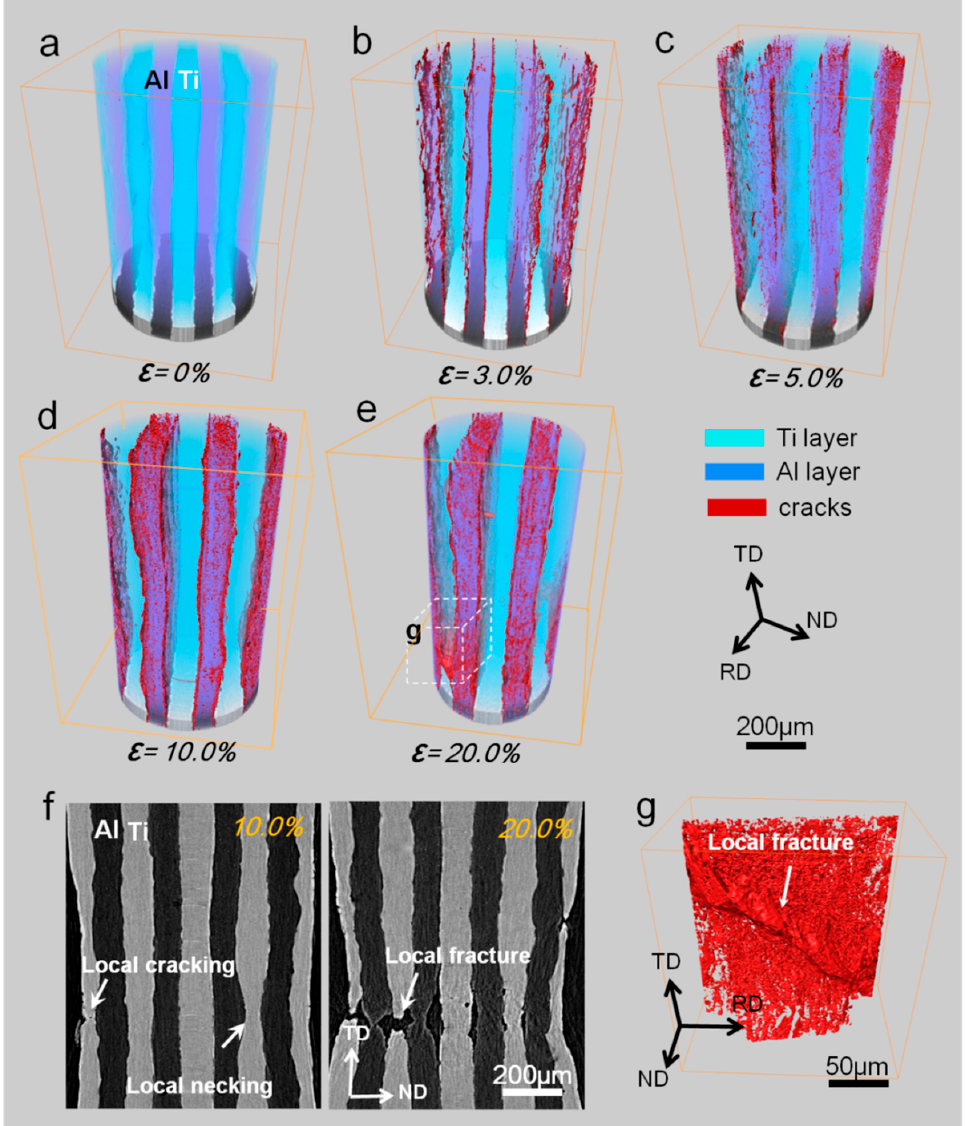
Figure 7. 3D rendering of LMC based on the in-situ µ CT [38]: ( a – e ) distribution of cracks in the LMC tensile sample at various macro strains; ( f ) 2D projections of TD-ND plane of the sample tensioned to 10.0% and 20.0%; and ( g ) magnified morphology of the local fracture in the Ti layer of LMC in white dotted-line box in ( e